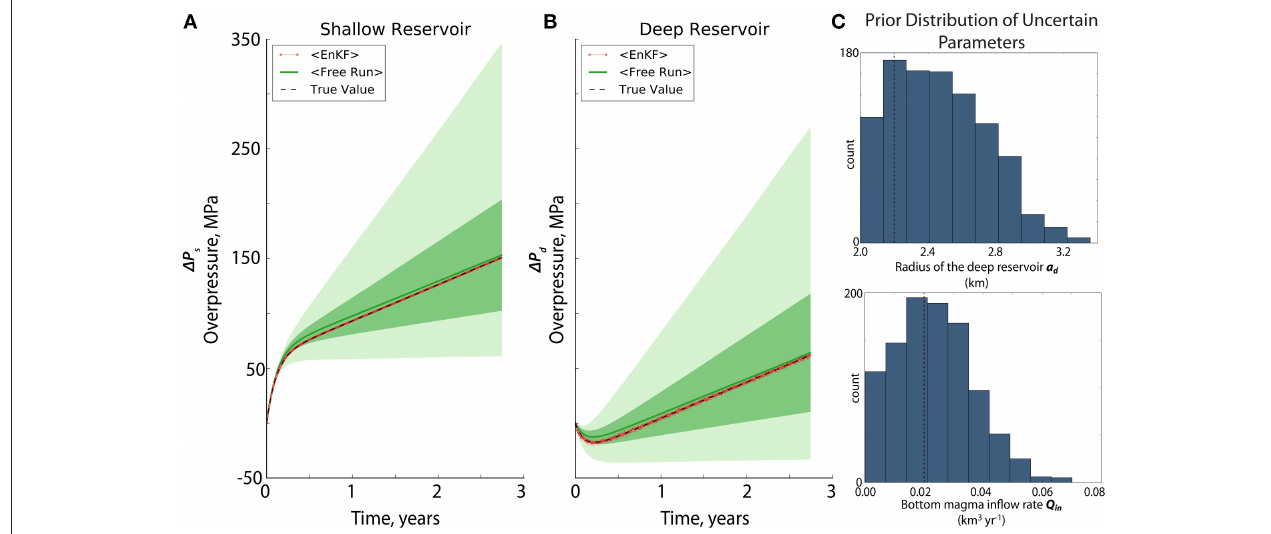
FIGURE 3 | The evolution of the overpressures after performing the state estimation (A,B) given that the initial ensemble of the uncertain parameters (C) are non-Gaussian, centered on their true values (black broken lines). In (A,B) the black broken line represents the true value of the overpressures. The green ones represent the model forecasts where the green solid line is the mean, the dark green fill is the spread (1 σ ) and the light green fill covers the full extent of the ensemble (i.e., [min, max]). The red ones represent the result of EnKF where the red solid line is the mean, the dark red fill is the spread (1 σ ) and the light red is the full extent of the ensemble. Notice that the spread of the ensemble is very narrow for the assimilation case ( 10 4 –10 6 ∼